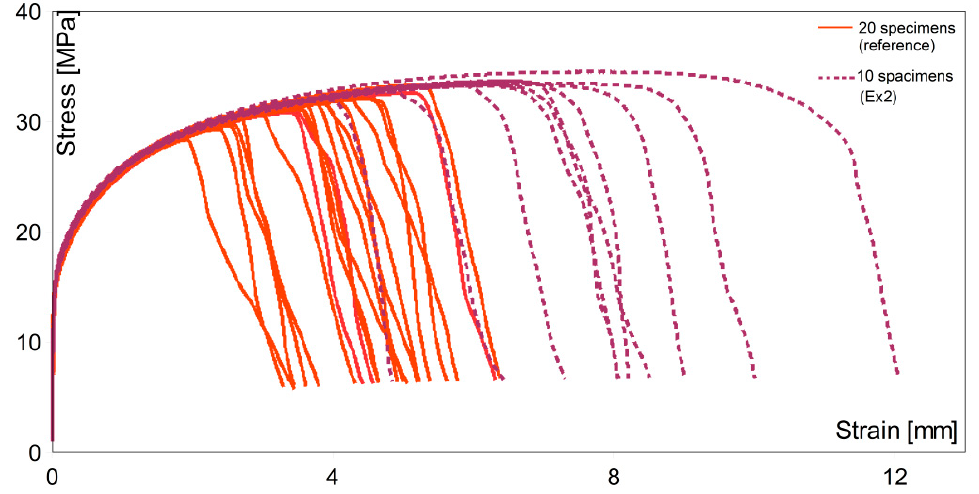
Figure 9. The stress versus the nominal strain curves for the specimens from the reference set and experimental (Ex2) set.